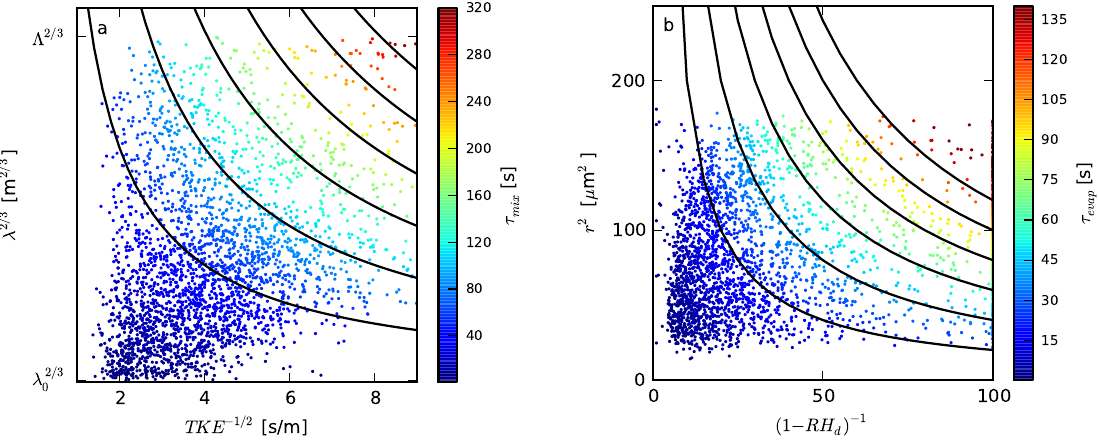
Fig. 15. As Fig. 14 but at the height of 1200m (i.e., at the top of the stratocumulus